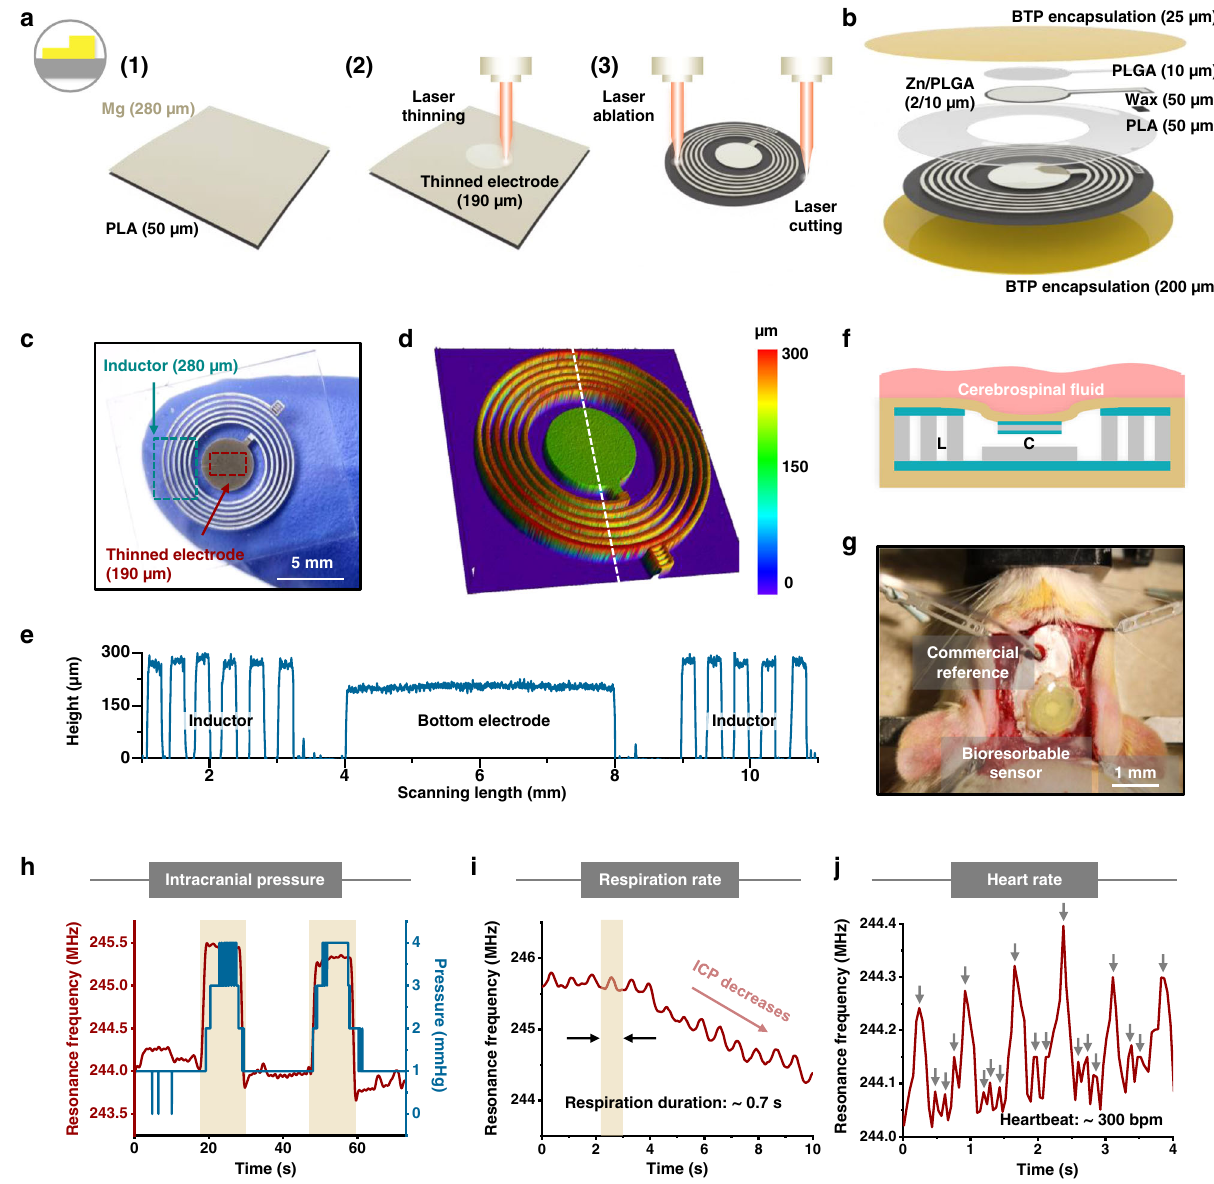
Fig.3|Strategyforthinningmaterialstructuresusedinwireless,bioresorbable physiological monitors. Procedures. a Schematic illustration of the process appliedtoaninductorwithathinnedbottomelectrode,asakeycomponentinsuch